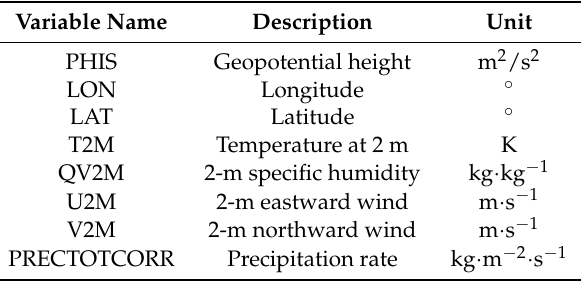
Table 2. MERRA-2 variables used in this study.